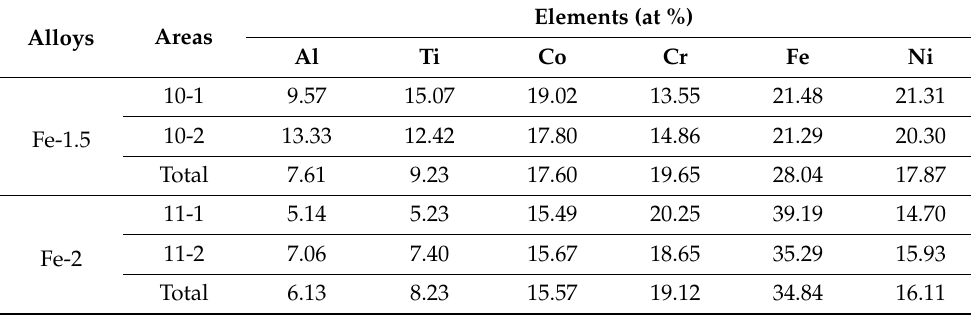
Figure 6. Microstructure and XRD results for Al0.5CoCrFe x NiTi0.5 HEAs: ( a ) Fe-1.5 alloy, ( b ) Fe-2 alloy; and ( c ) XRD results. Table 7. EDS results for Al0.5CoCrFe x NiTi0.5 HEAs.